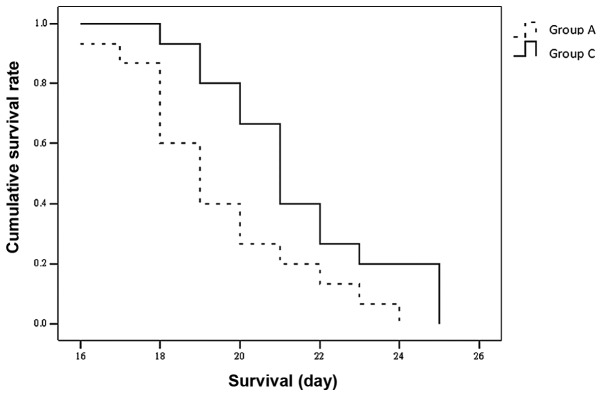
Survival time. Survival times of 16–24 days (mean, 19.47±2.232 days) and 18–25 days (mean, 21.47±2.232 days) were observed in groups A and C, respectively. The difference was statistically significant (P<0.05).